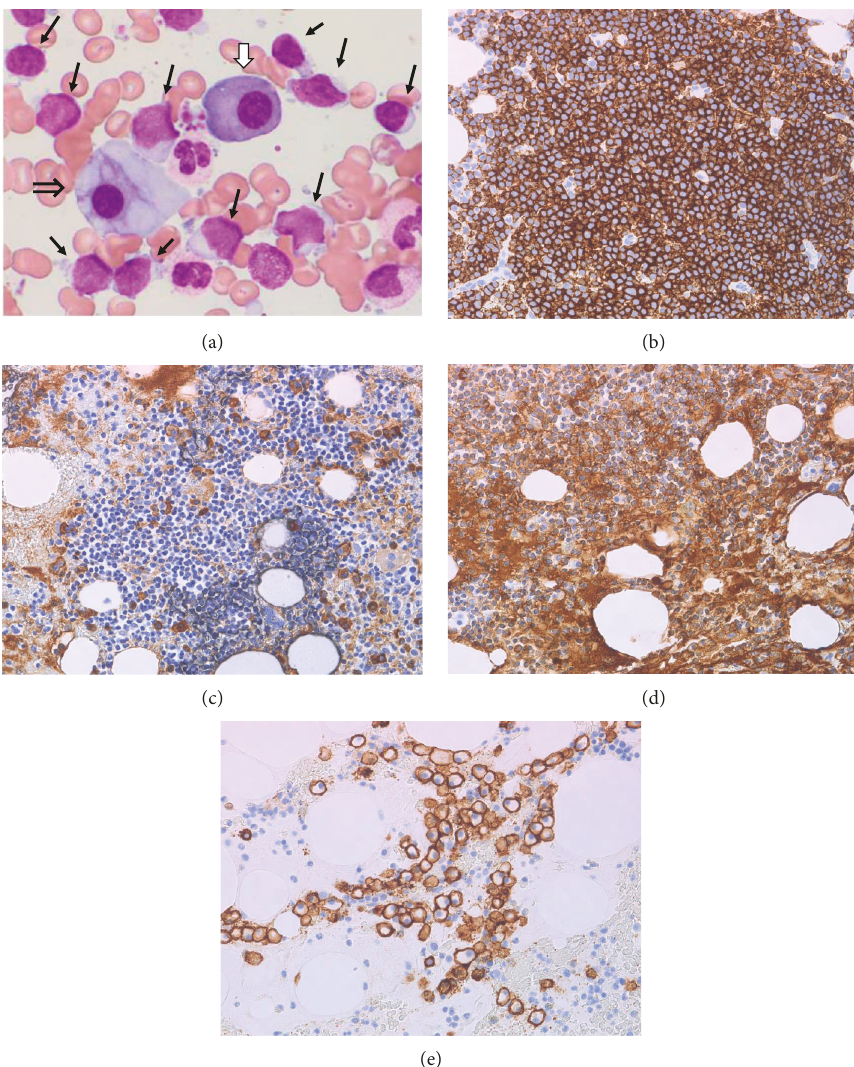
Figure 4: Immunohistochemical staining of bone marrow before R-THPCOP. (a) May Grunwald–Giemsa staining ( × 1000). (b) CD20 ( × 40). (c) IgA chain ( × 40). (d) IgM chain ( × 40). (e) CD138 ( × 40). Black arrow: lymphoma cell; white arrow: normal-sized plasma cell; double arrow: large-sized plasma